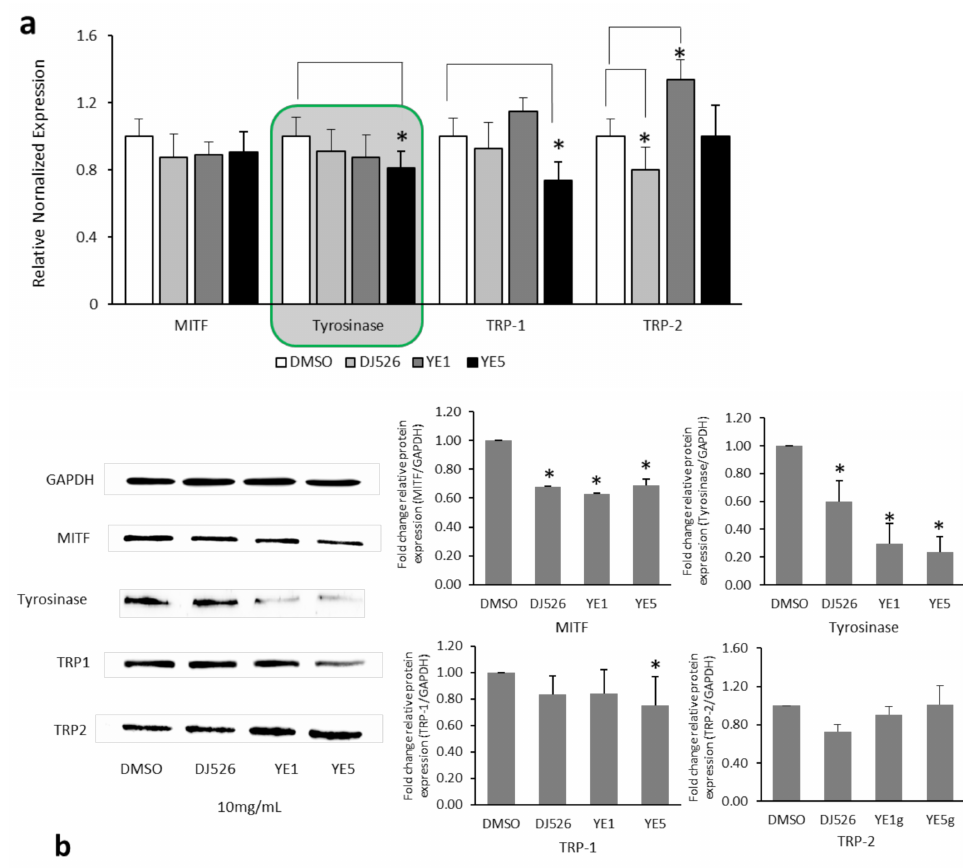
Figure 3. Melanogenesis-related gene and protein expression of crude extracts of DJ526 and 10 mg/mL YE1 and YE5-treated DJ526 seeds. ( a ) mRNA expression of melanogenesis-related genes, including MITF, tyrosinase, TRP-1, and TRP-2, were analyzed by real-time PCR. ( b ) Western blot analysis of protein levels of melanogenesis-related proteins. GAPDH was used as an internal control. Student’s t -test was used for statistical analyses, * p < 0.05 indicates statistically significant differences compared with the control